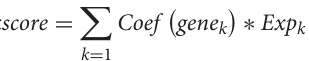
Frontiers in Genetics |